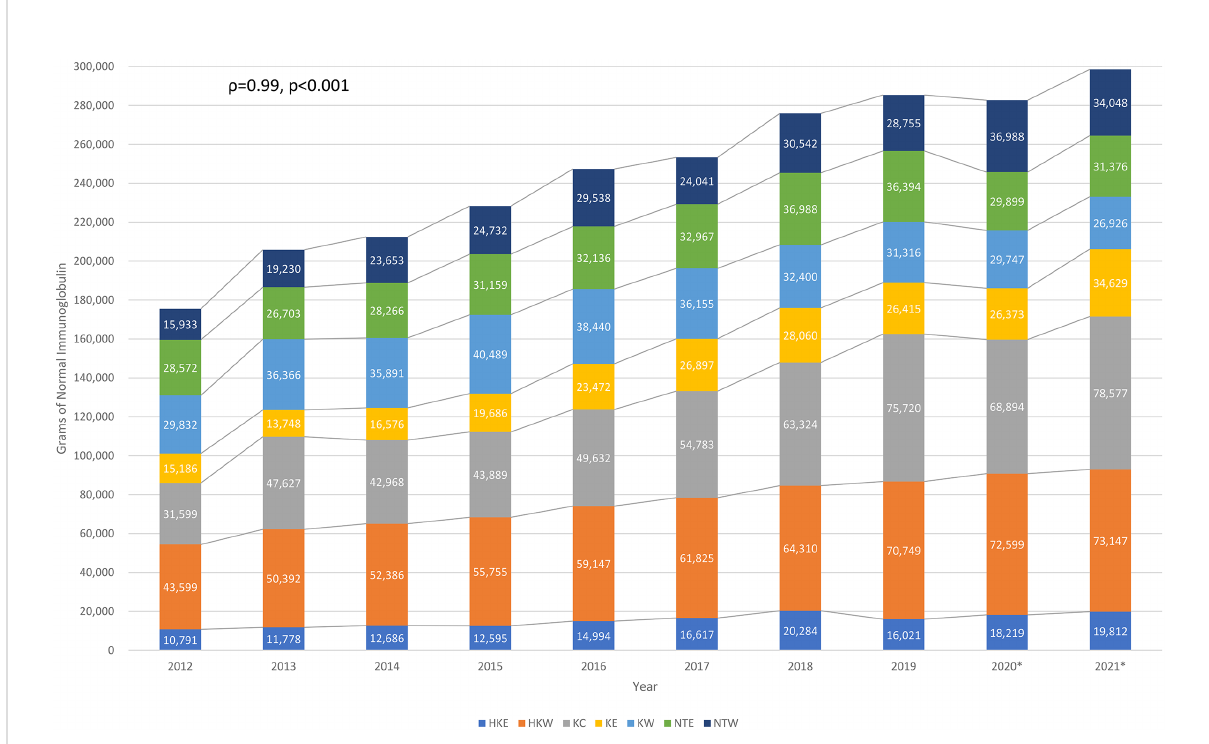
FIGURE 1 Longitudinal normal immunoglobulin consumption over the past decade in Hong Kong. HKE, Hong Kong East Cluster; HKW, Hong Kong West Cluster; KC, Kowloon Central Cluster; KE, Kowloon East Cluster; KW, Kowloon West Cluster; NTE, New Territories East Cluster; NTW,